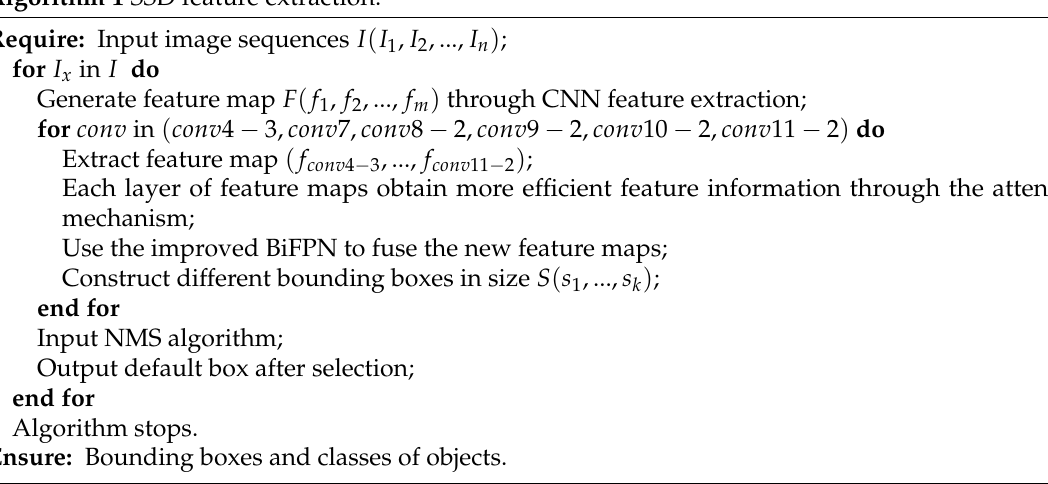
Algorithm 1 SSD feature